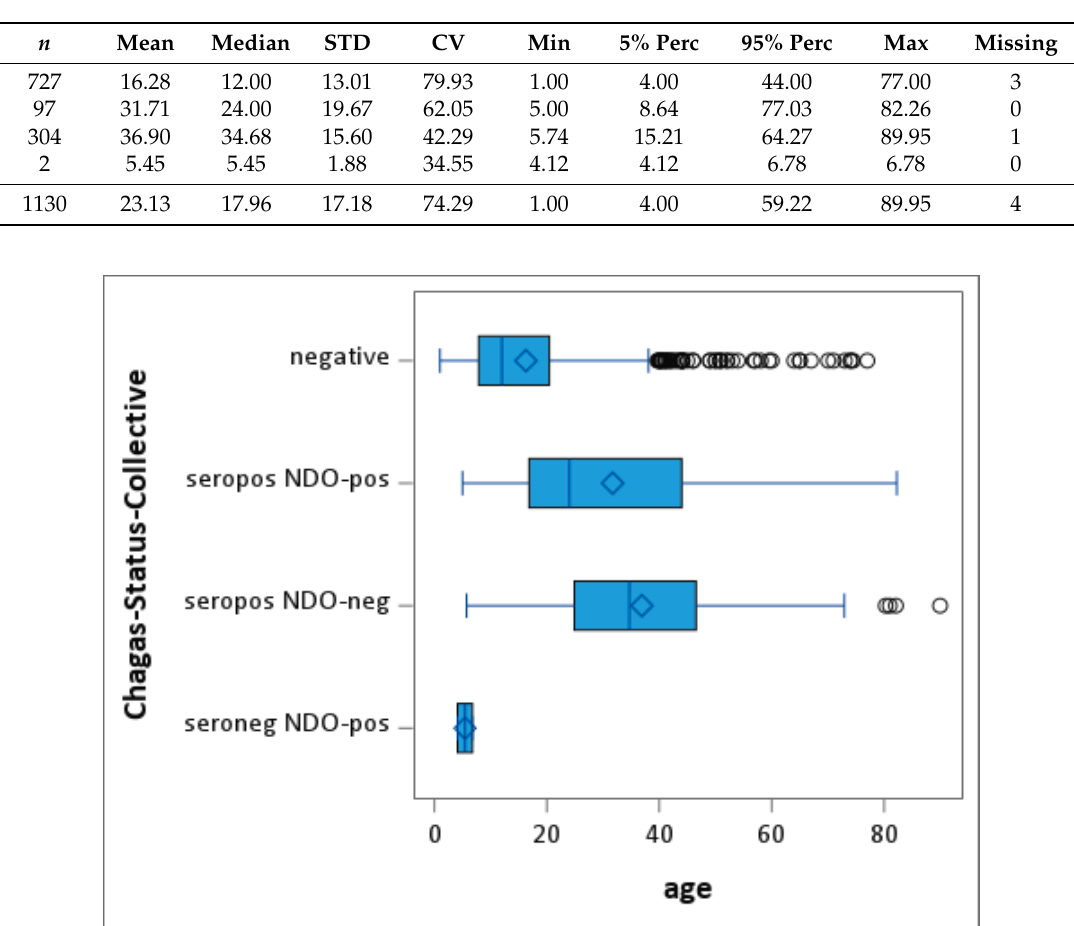
Table 4. Chagas status in the entire study population by village ( n = 1134). Village